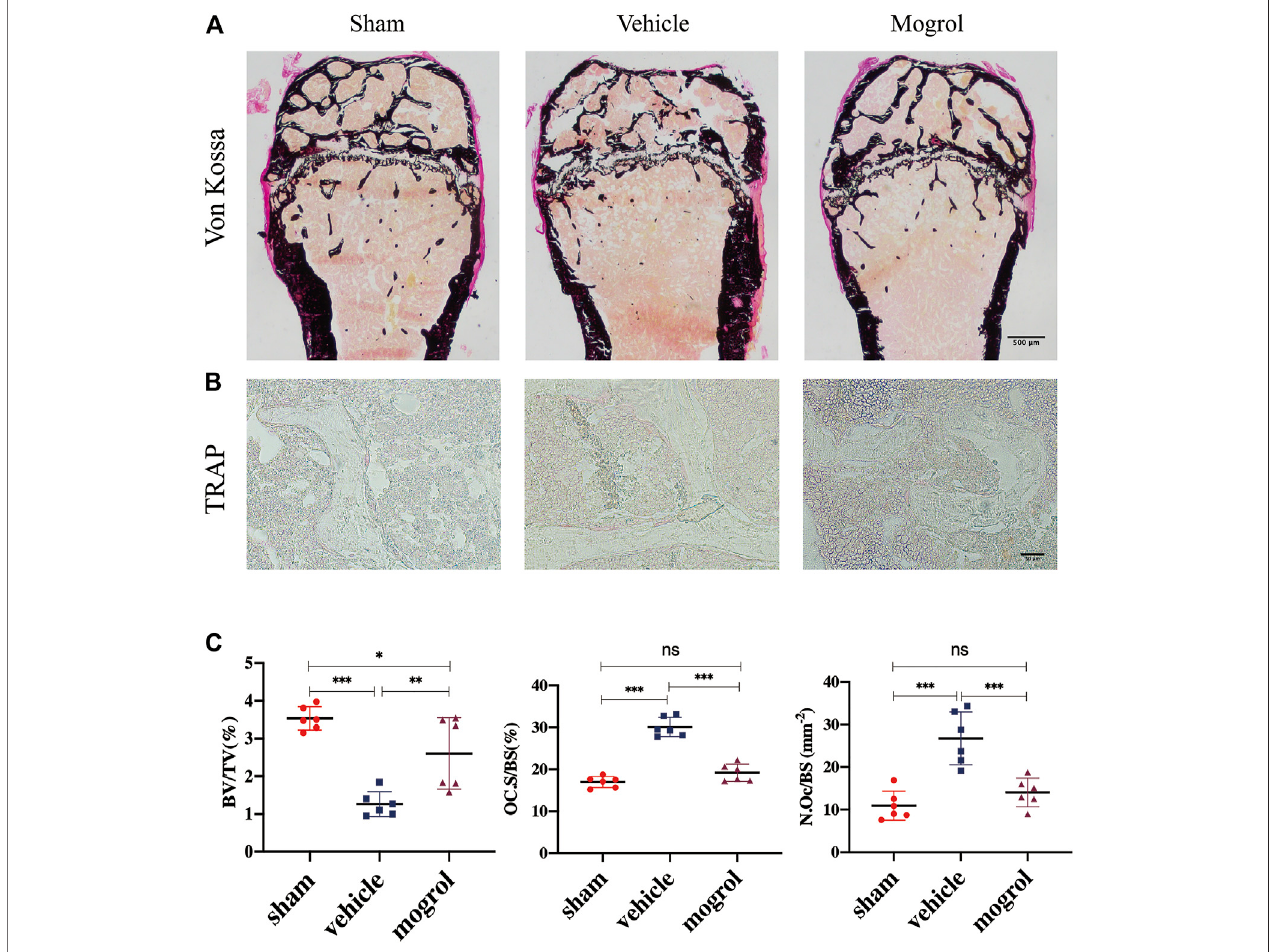
FIGURE 7 | Mogrol relieved bone mass loss in OVX mice by suppressing osteoclast differentiation or activity. (A) Images of Von Kossa staining of the femurs. (B) Images of TRAP staining. (C) Quantitative analysis of BV/TV in Von Vossa, Oc. S/BS, and N. Oc/B in TRAP staining ( n = 6).